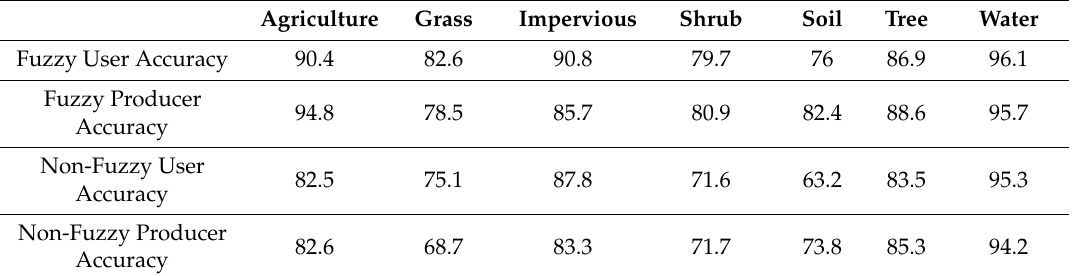
Table 4. MULC mean class accuracies across 30 EnviroAtlas communities.